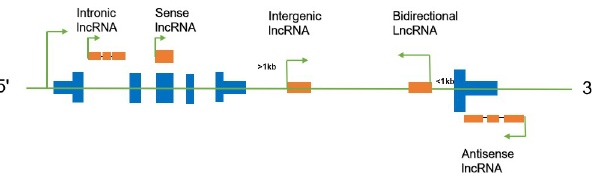
Fig 10. Five categories of